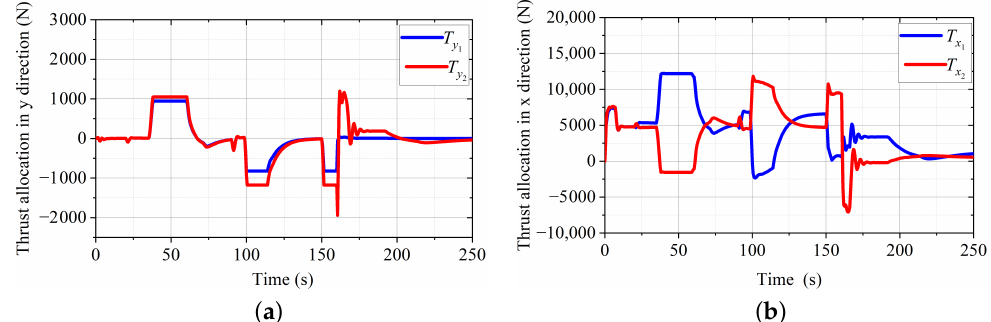
Figure 9. Thrust allocation results of reference control signals. ( a ) Thrust allocation in y direction; ( b ) Thrust allocation in x direction.